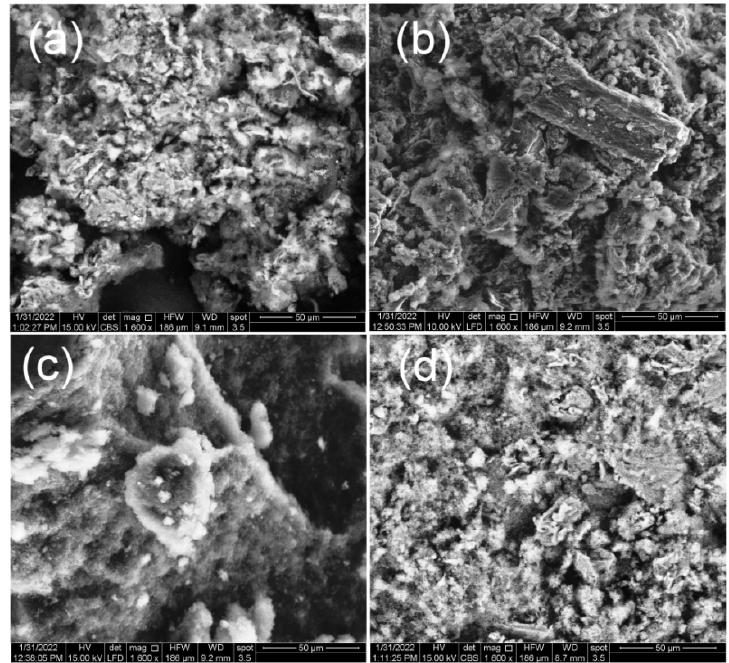
Figure 4. SEM images of: ( a ) TiO 2 , ( b ) TiO 2 –CuO, ( c ) PANI, and ( d ) PANI@TiO 2 –CuO.